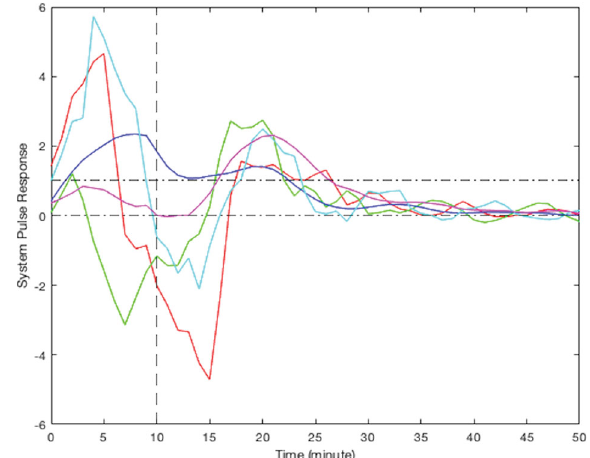
Fig. 7 Pulse response for participants in cluster 3, two rounds of increases in smoking odds. The vertical line at the 10-min mark on the x -axis re fl ects the time when the stress probability returned to